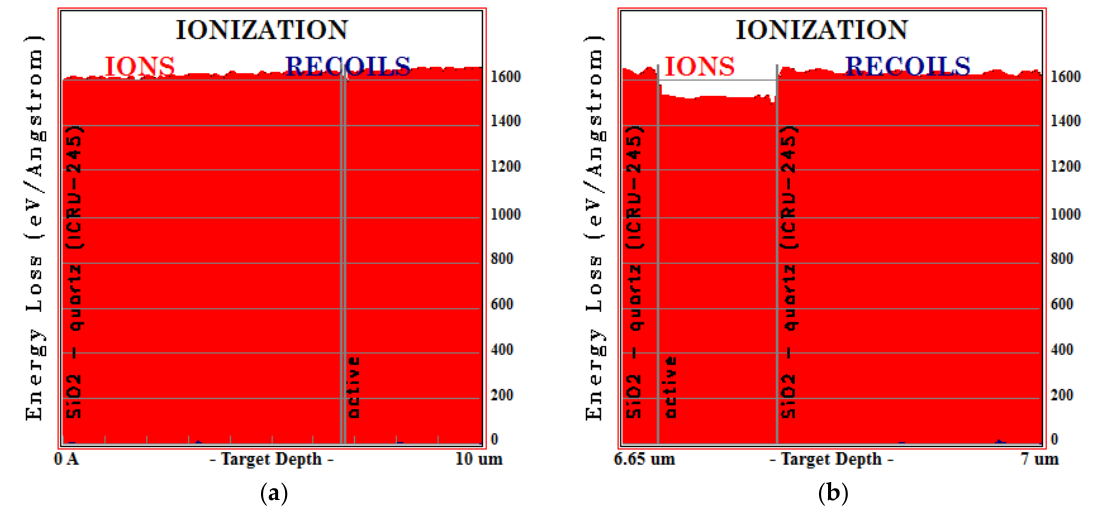
Figure 22. Effective LET in the different layers of the DUT for Xe (refer FIB cross section of Figure 4). ( a ) shows the long track of the ion stopping power and ( b ) a detailed view on the active silicon area of the DUT.